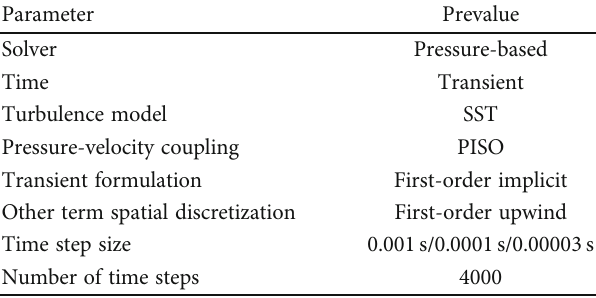
Table 3: Fluent simulation preset